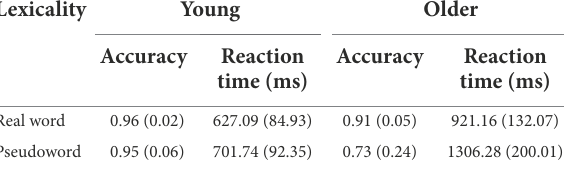
TABLE 3 Descriptive statistics of participants’ lexical decision performance, grouped by age and lexicality.